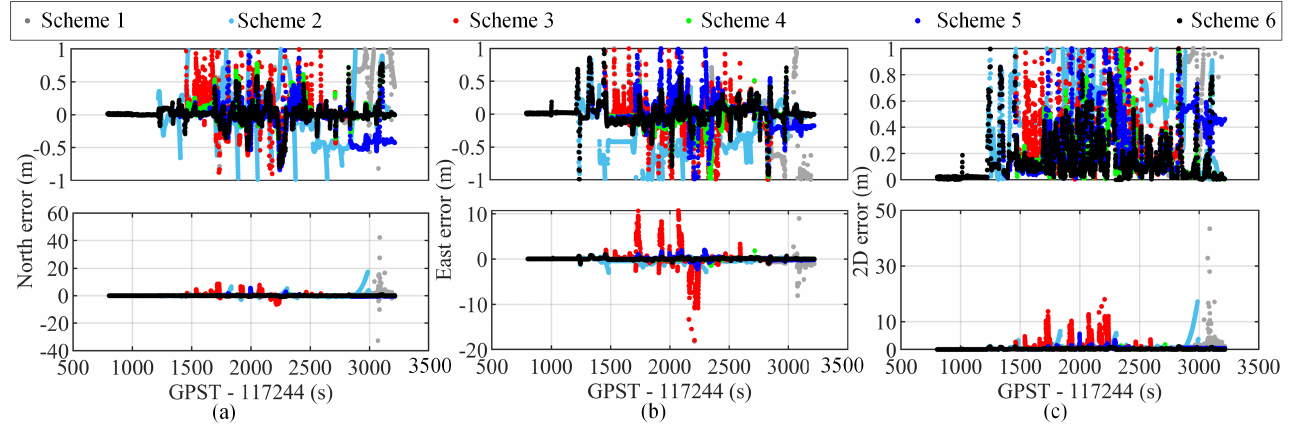
Figure 11. Comparison of the positioning errors under different schemes. ( a ) North. ( b ) East. ( c )